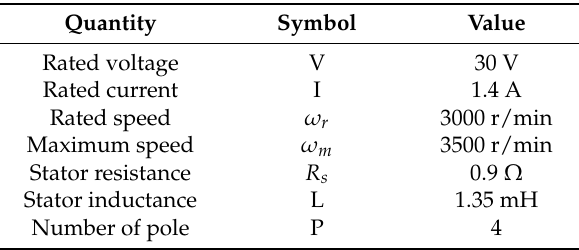
Table 1. The properties of a SPMSM